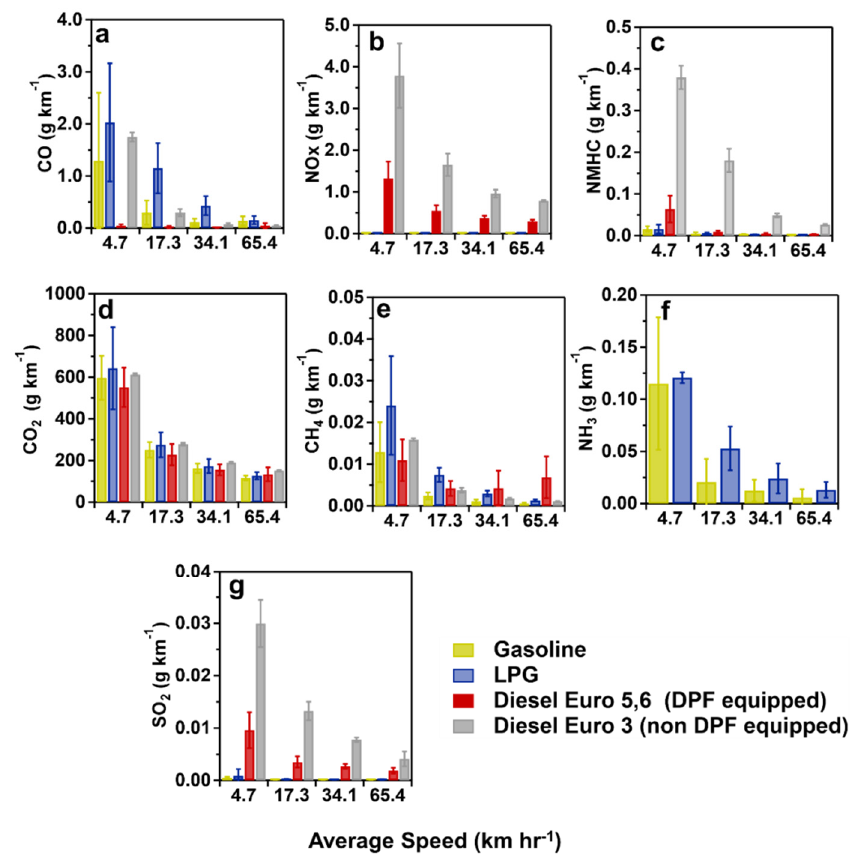
Figure 2. Trends concerning emission rates of ( a ) CO, ( b ) NOx, ( c ) NMHC, ( d ) CO 2 , ( e ) CH 4 , ( f ) NH 3 , and ( g ) SO 2 measured during the National Institute of Environmental Research (NIER) cycle tests performed on vehicles powered by different fuels.